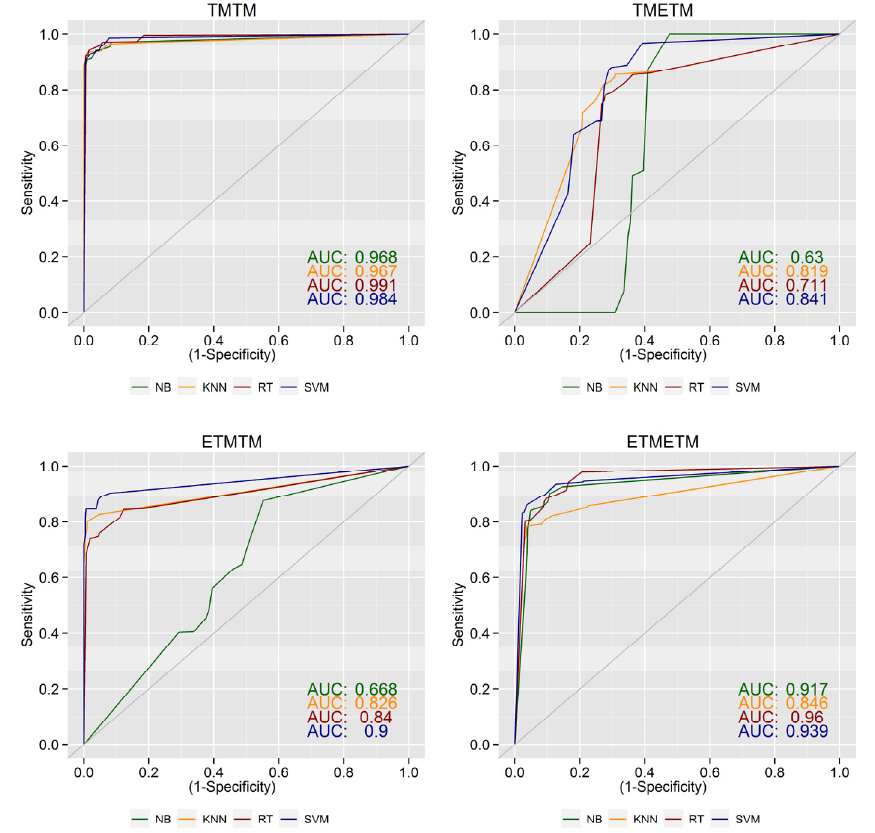
Figure 12. Classifier performance for different training-testing scenarios on MR image